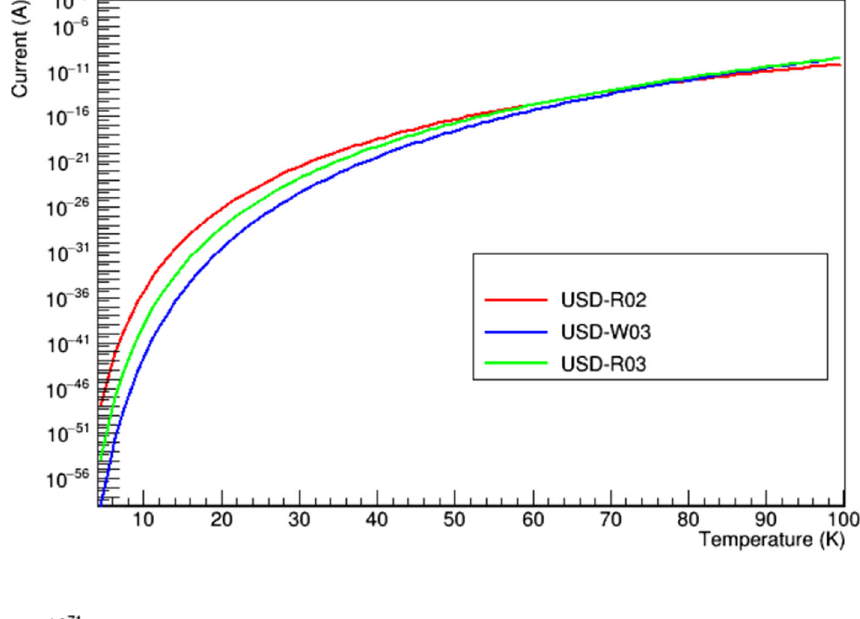
Fig. 10 Projected variation of the resistance with temperature for a PPC detector using the parameters obtained for the a-Ge used in detectors USD-R03, USD-R02 and